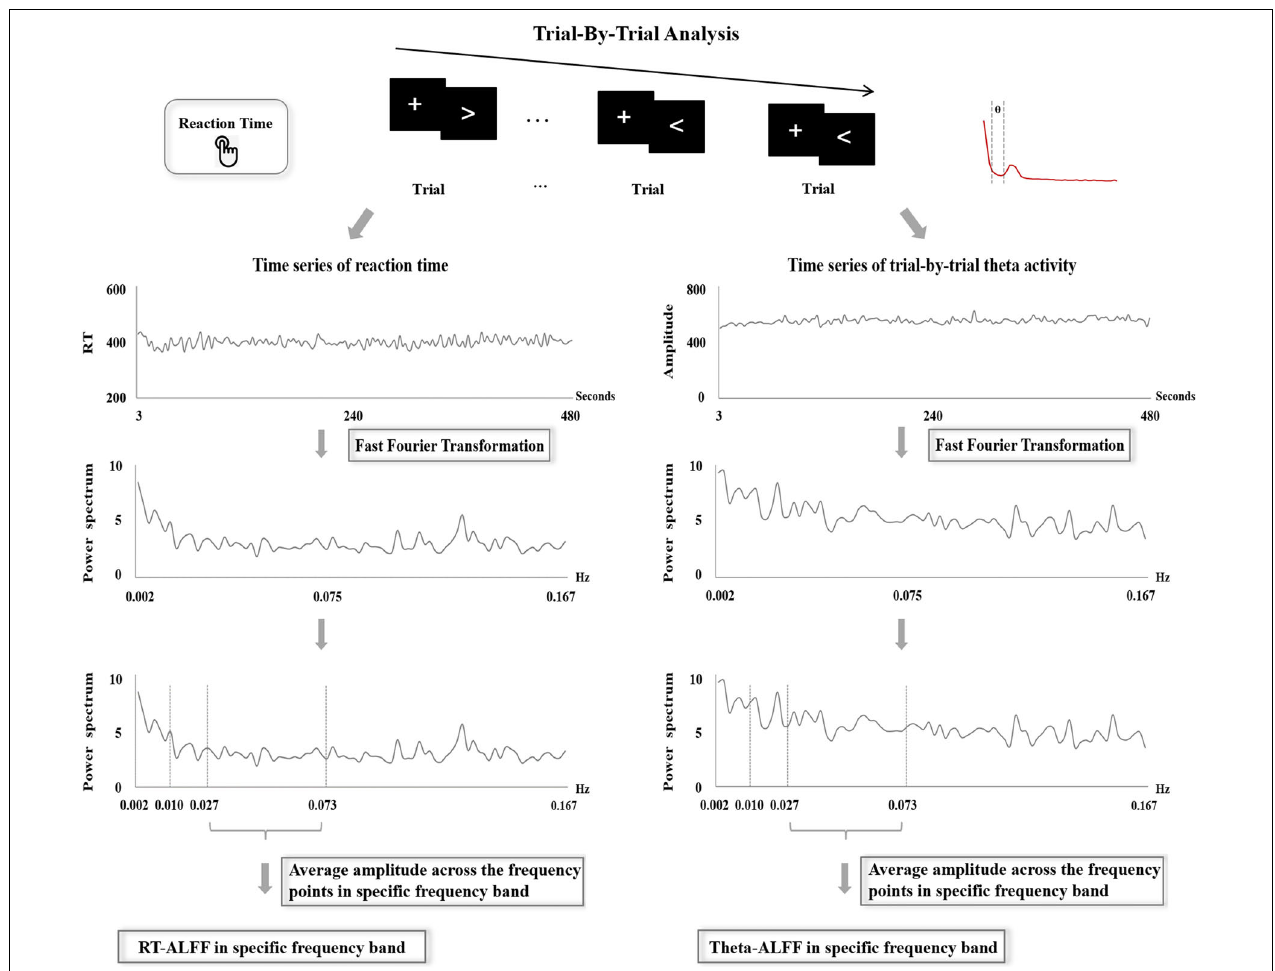
FIGURE 2 | The procedure of the frequency-dependent analysis of reaction time and trial-by-trial theta activity.